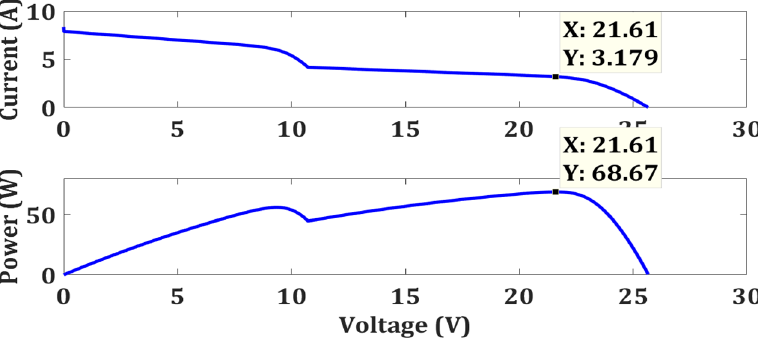
Figure 38. Characteristic curves of 2S2P PV system for test case 2 .